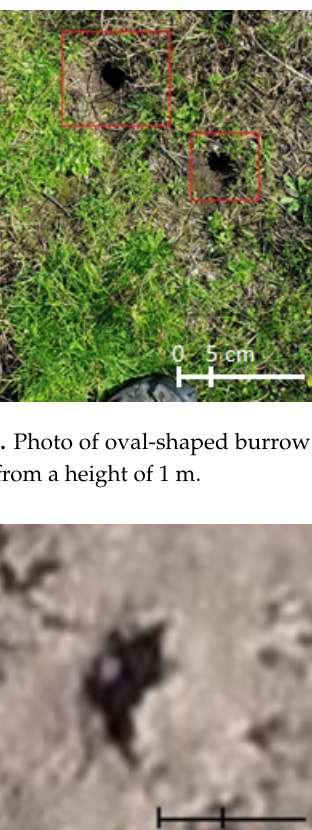
Figure 4. Photo of a collapsed hole with an irregular shape, taken with a UI DJI Phantom 4 Pro camera, from a height of 30 m.